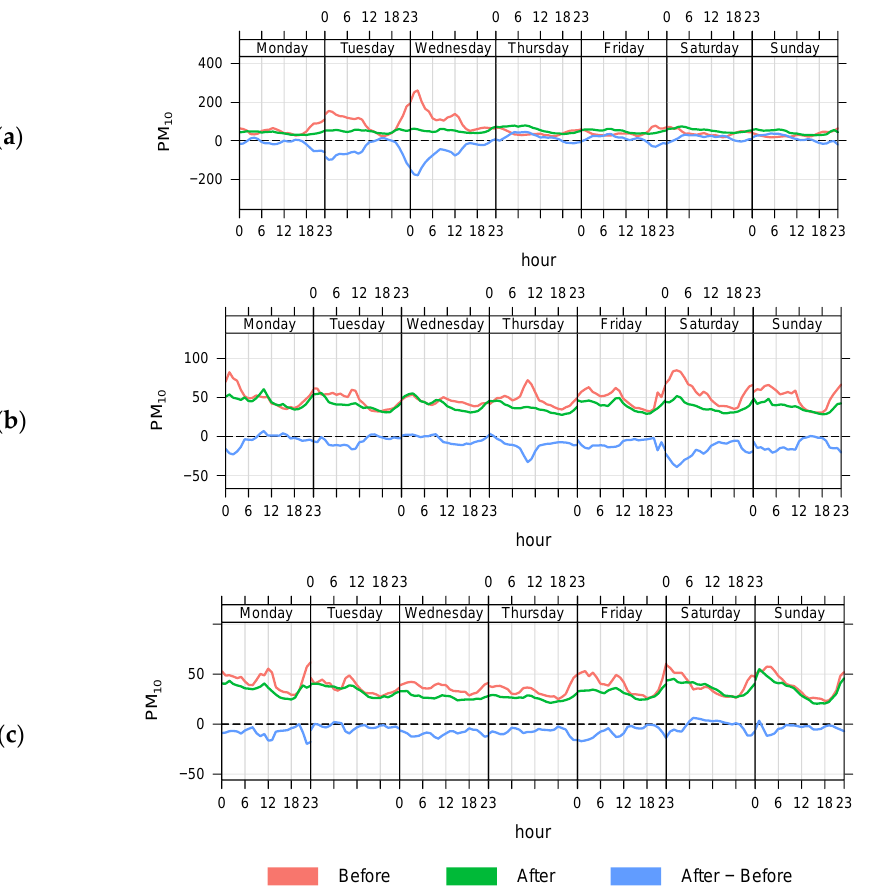
Figure 5. Temporal variations in PM 10 (μg/m3) for Kadikoy station with three Phases: ( a ) Phase I